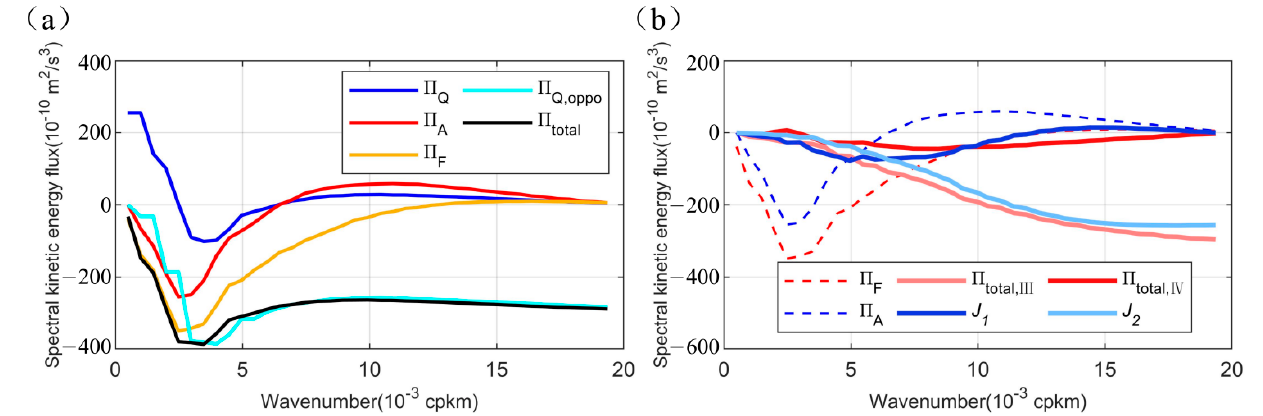
Figure 3. Spectral kinetic-energy fluxes. ( a ) Time-mean of Π Q , Π A , Π F , Π Q,oppo , and Π total [Equations (6), (22), (16), (7), and (15)]. ( b ) Time-mean of Π A , Π F , the transport of large-scale kinetic energy Π total, Ⅲ , Π total, Ⅳ [Equation (15)], J 1 , J 2 [Equation (23)]. All quantities are for the KE box 1 region from Figure 2. Analysis here is based on the surface velocity output from the ECCO2 model without data preprocessing.